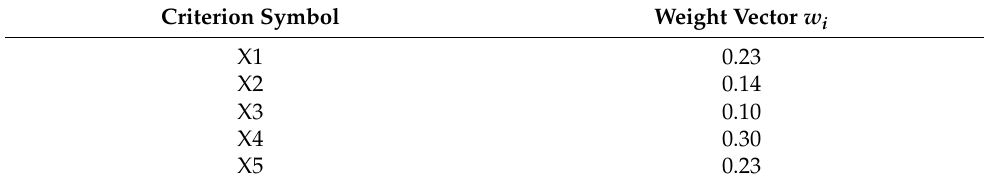
Table 7. The overall weight vector w i